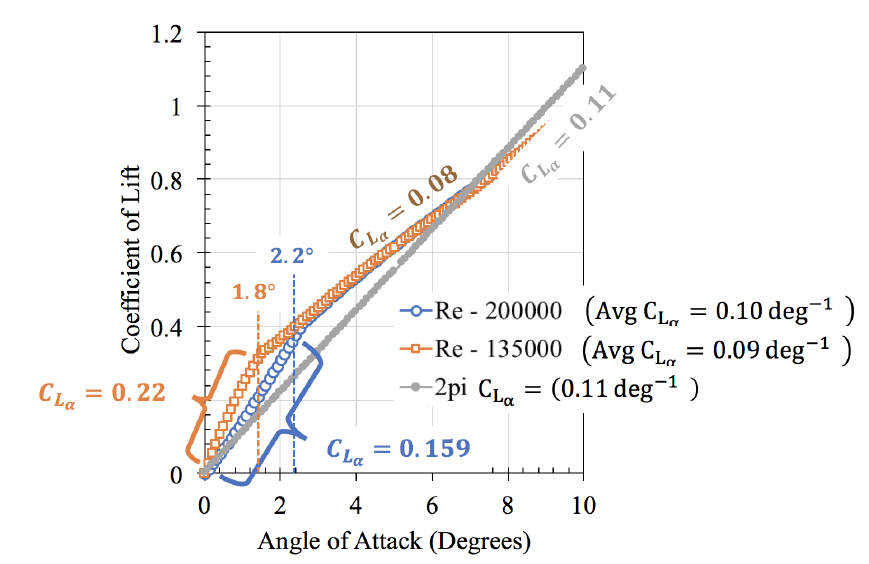
Figure 9. Comparison of lift coefficient at different Reynolds